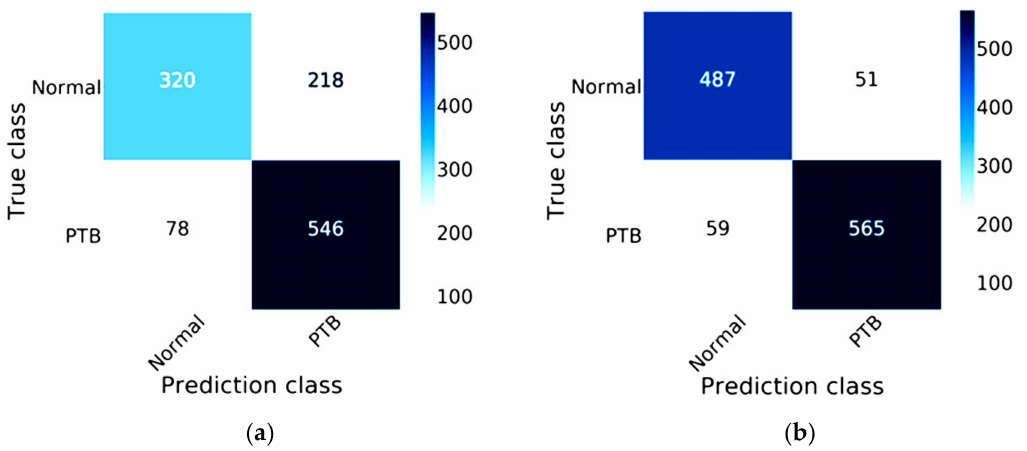
Figure 9. Confusion matrix of MobileNet: ( a ) the traditional model results of MobileNet; ( b ) the results of MobileNet combined with Mish and Nadam.